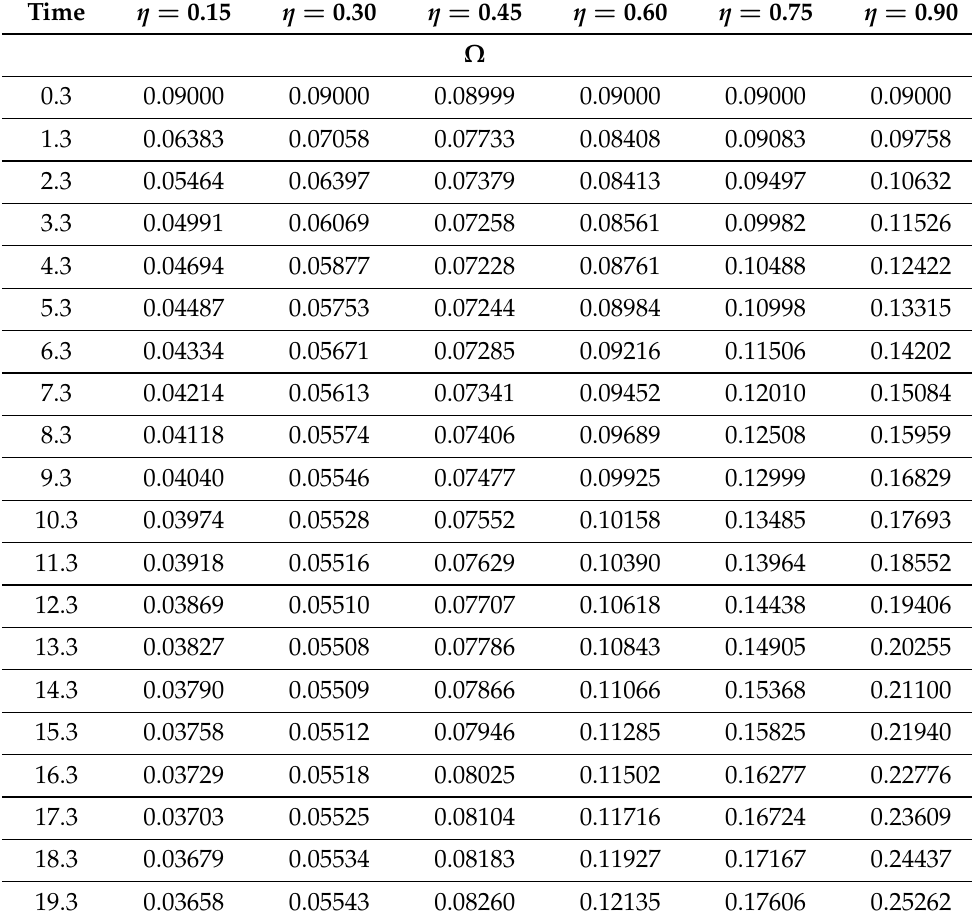
Table 1. Representation of impact of fractional order η on stability condition Ω .